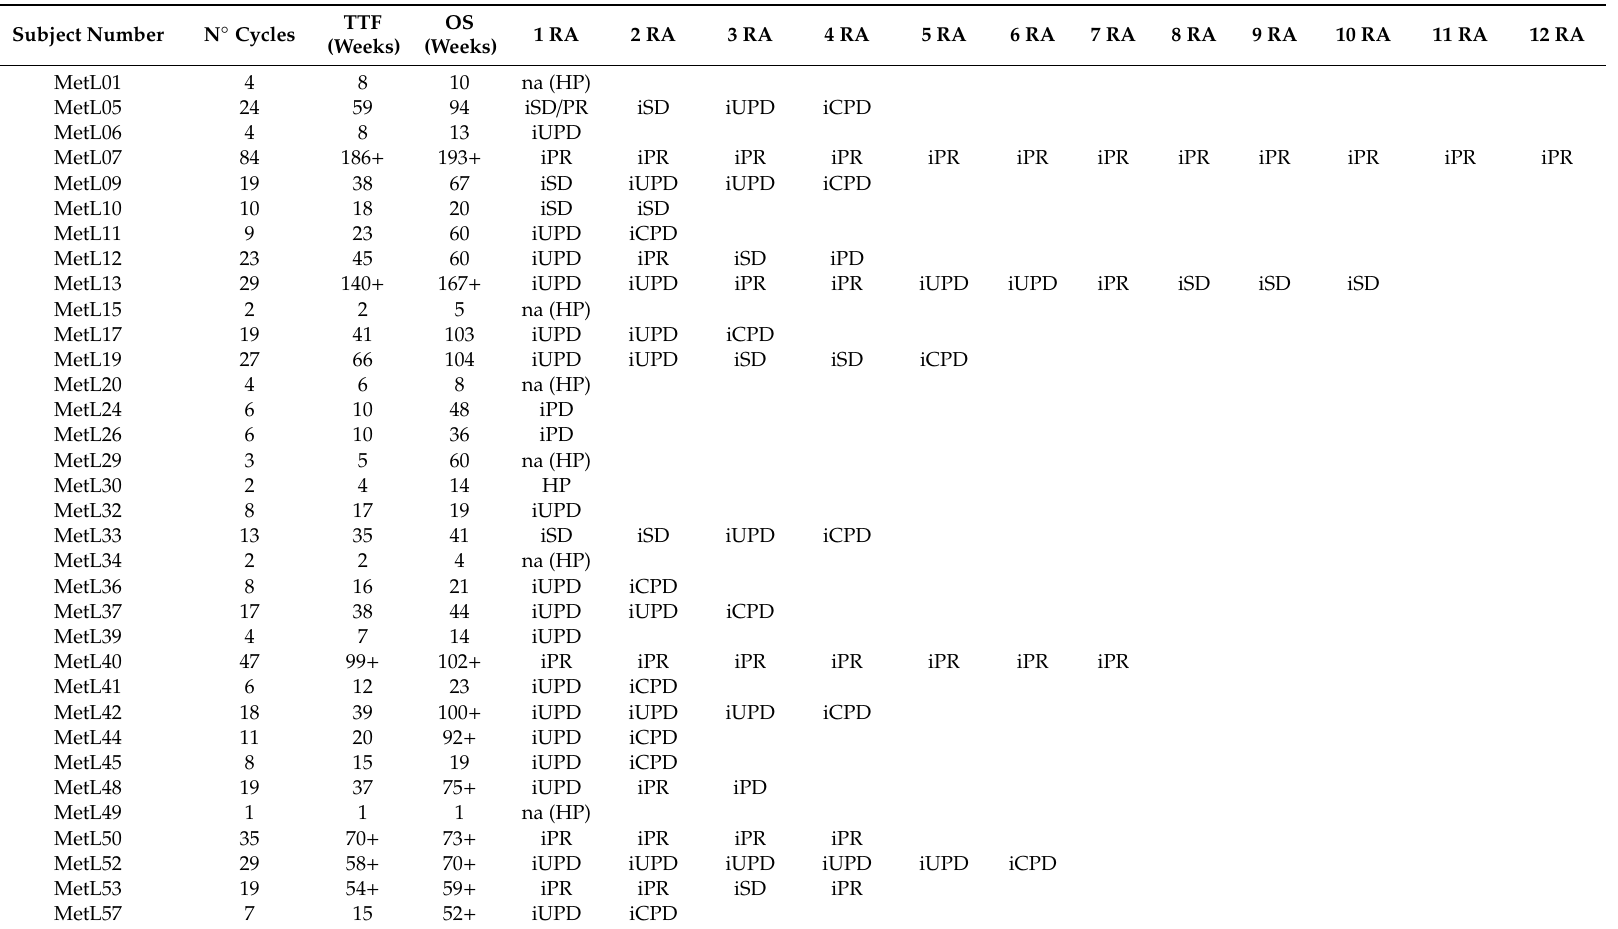
Table 1. NSCLC Nivolumab-treated cohort. For each patient the (i) number of cycles of nivolumab therapy performed, (ii) time of treatment failure (TTF), (iii) overall survival (OS), (iv) iRECIST classification for the radiological assessments (RA), are reported: complete response (iCR), partial response (iPR), stable disease (iSD), unconfirmed progressive disease (iUPD), confirmed progressive disease (iCPD) and hyper-progression (iHP). Patients continuing the therapy are highlighted in